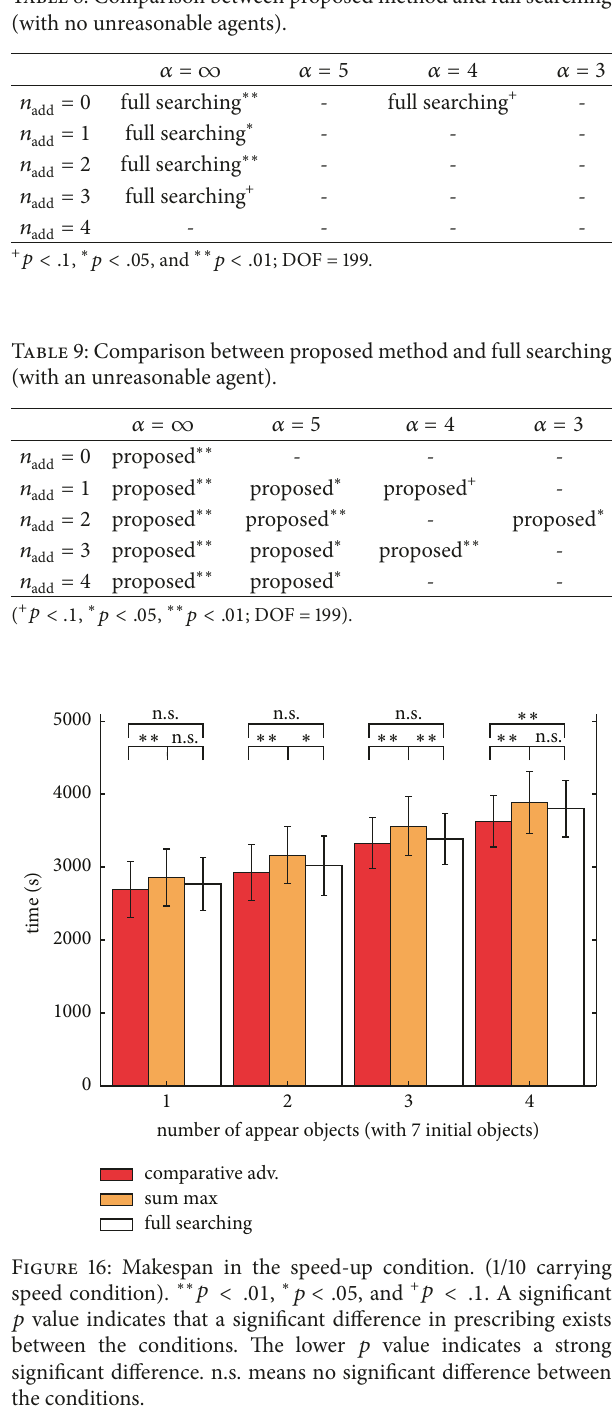
Table 10: Moving velocity (object ID in